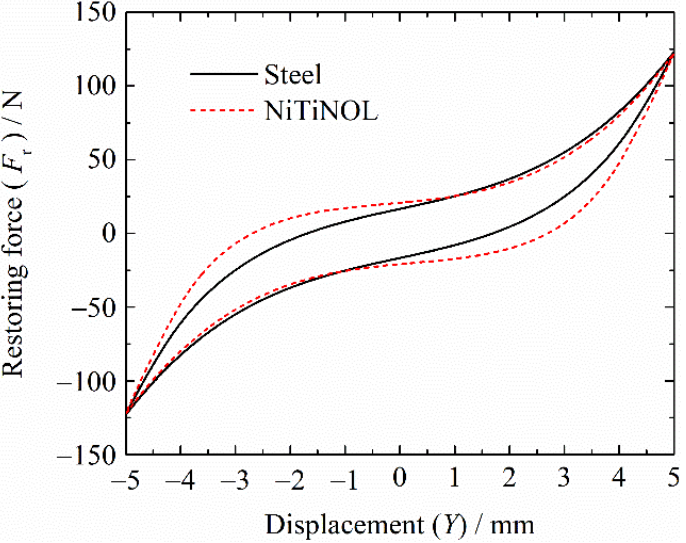
Figure 2. Restoring forces of the isolators with a steel wire rope and a NiTiNOL wire rope.